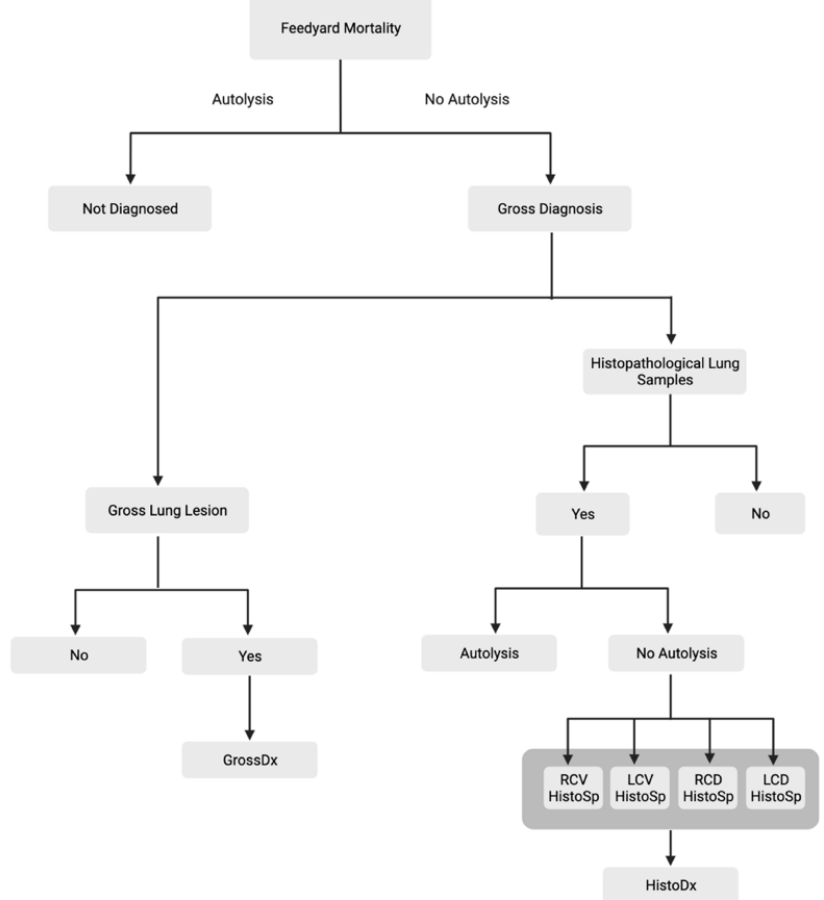
Figure 1. Right-sided view of gross lesion characteristics representing the three main gross pulmo- nary pathological diagnoses in this study: ( a ) bronchopneumonia (BP), ( b ) acute interstitial pneu- monia (AIP), and ( c ) bronchopneumonia with an interstitial pneumonia (BIP).